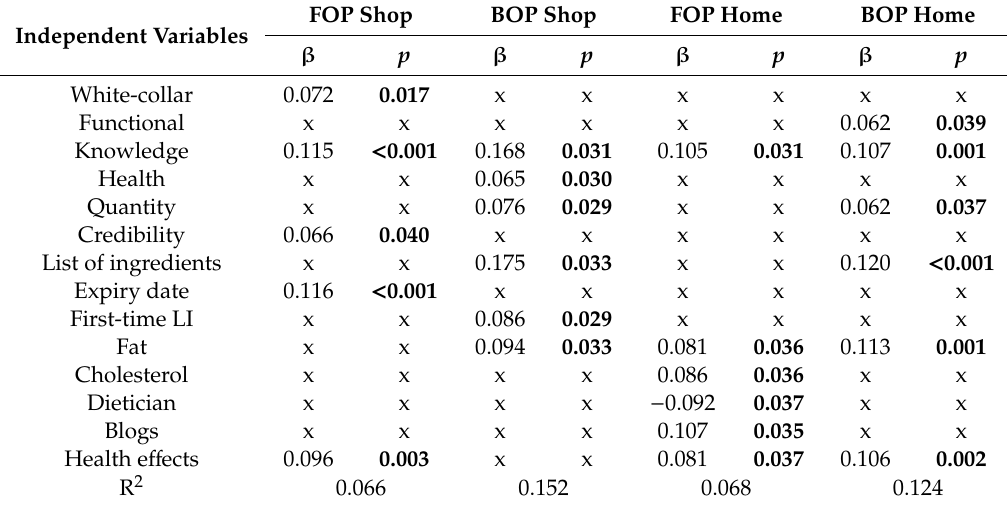
Table 20. Selected predictors of reading food labels—retrograde step regression